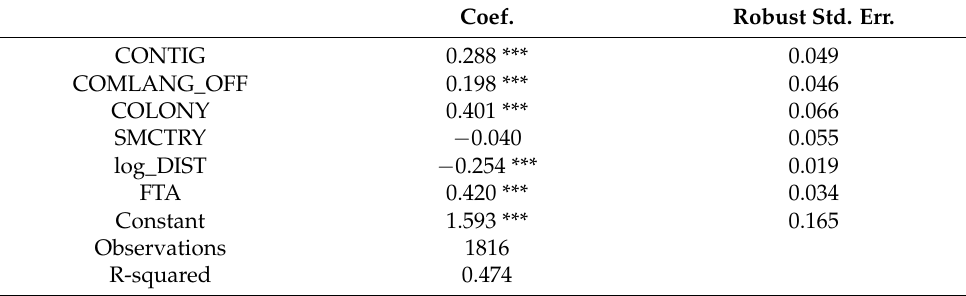
Table 9. Results of Equation